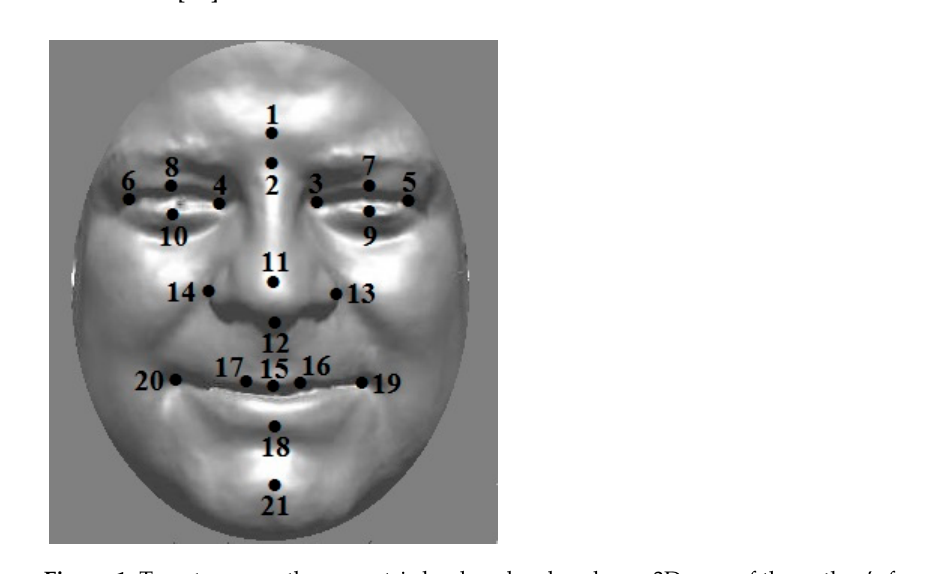
Figure 1. Twenty-one anthropometric landmarks placed on a 3D scan of the author’s face.